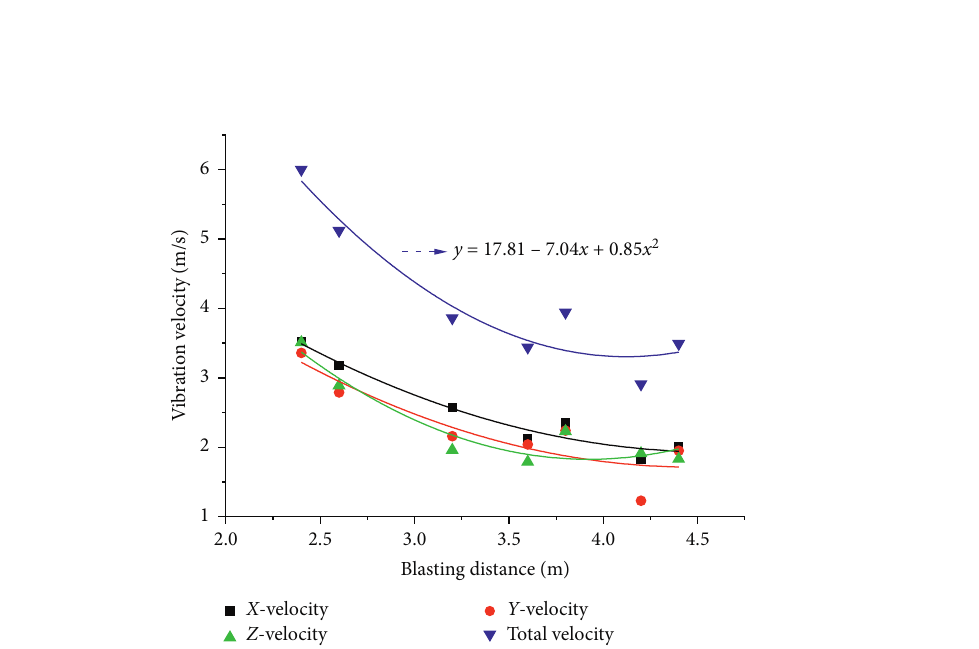
Figure 9: Blasting vibration velocity attenuation curve with distance.